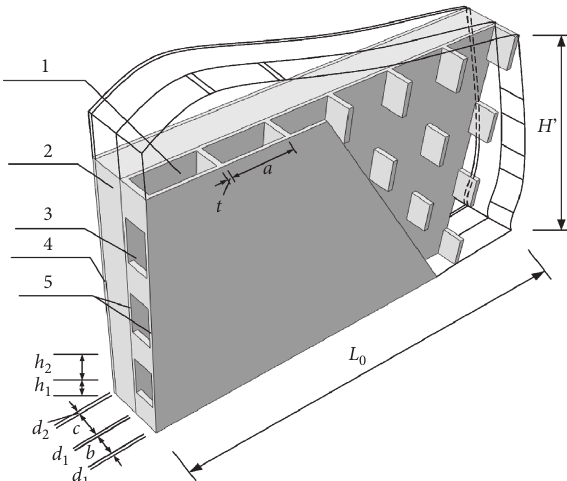
Figure 1: Schematic diagram of composite board. Notes:1, vertical gypsum cavity; 2, insulation board; 3, horizontal gypsum cavity; 4, externally bonded single gypsum board; 5, gypsum